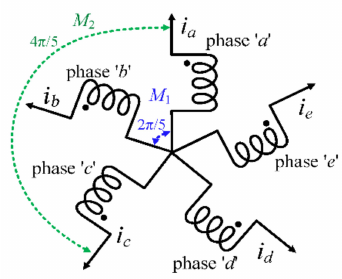
Figure 3. Five phase star connected